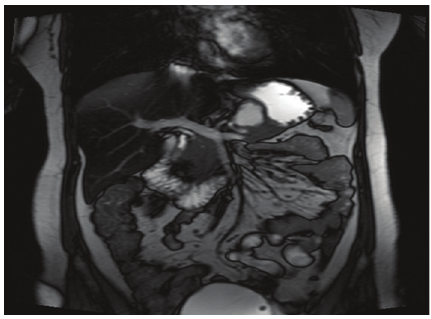
Figure 3: Abdominal MRI reveals a cystic lesion measured 4 × 2 cm in mid portion of